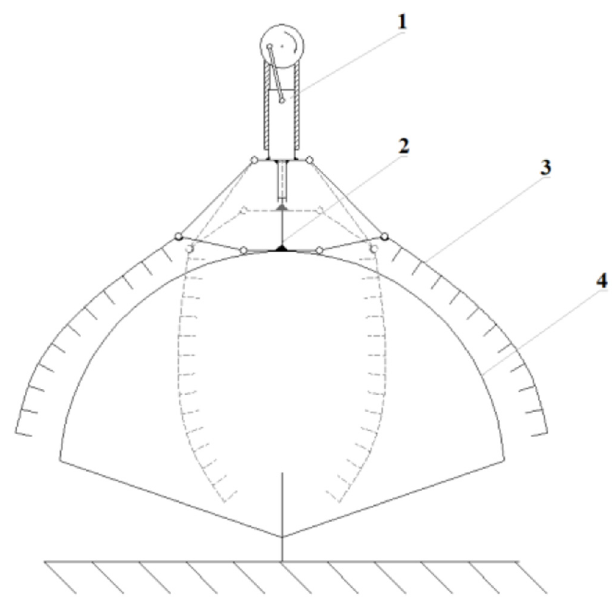
Fig. 2. Schematic diagram of mechanism.